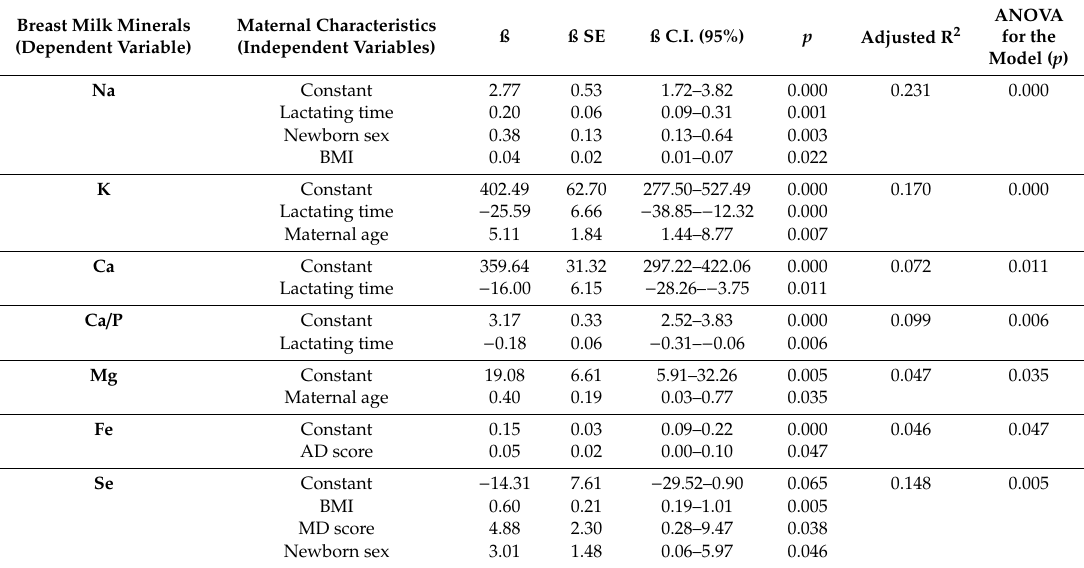
Table 7. Multiple regression analysis for modelling breast milk minerals. Breast Milk Minerals Maternal Characteristics ß ß (Dependent Variable) (Independent Variables)